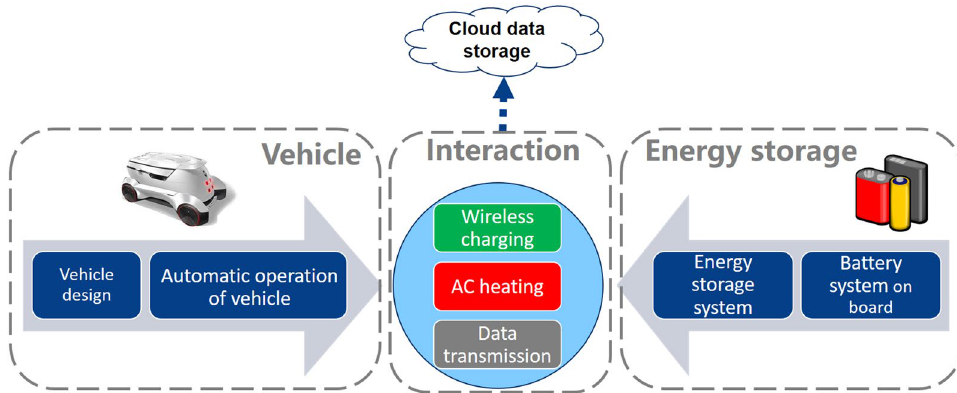
Figure 1 Overall structure of the platform